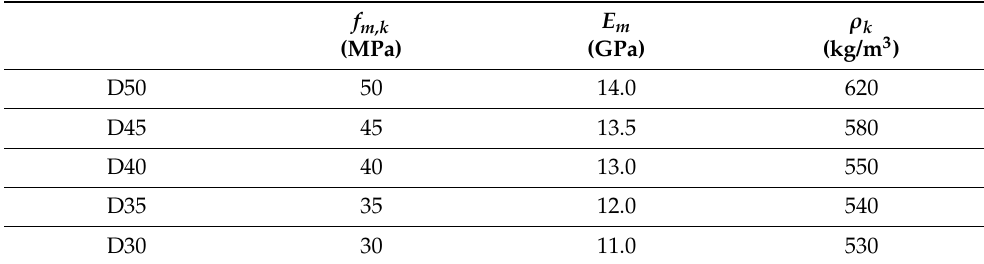
Table 3. Strength class properties as described in EN 338 [20] ( f m,k = 5th percentile of bending strength; E m = mean modulus of elasticity; ρ k = 5th percentile of density).